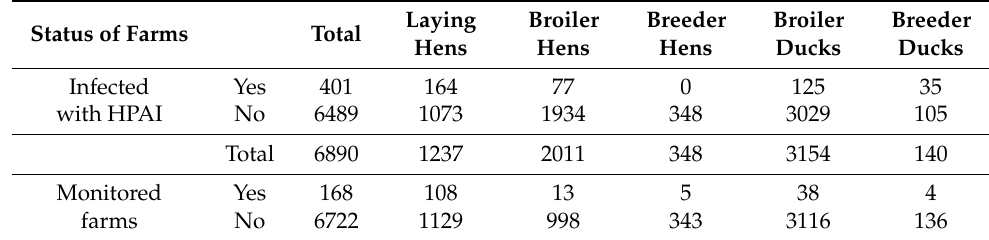
Table 1. Farms analyzed from the 2016–2017 HPAI outbreak.